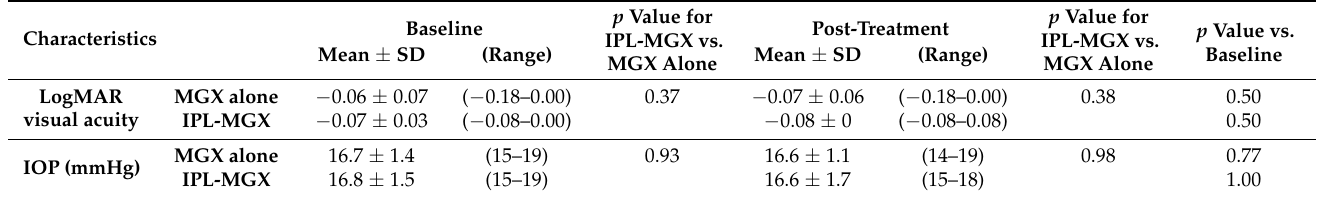
Table 6. Visual acuity and intraocular pressure of the patients with chalazion in intense pulsed light (IPL)–meibomian gland expression (MGX) ( n = 12) and MGX alone ( n = 12) groups before and four weeks after the final treatment